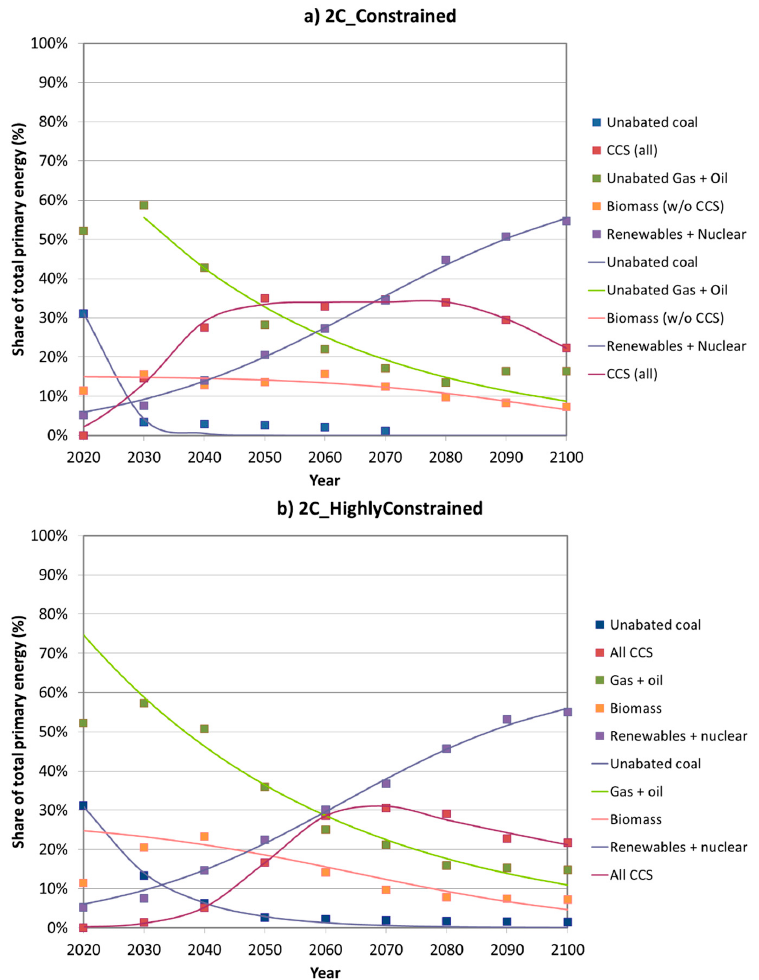
Figure 8. World share of primary energy use (%) for ( a ) 2C_Original and ( b ) 2C_HighlyConstrained scenarios. Notes: Symbols indicate data from scenario projections and solid lines indicate fit using a multiple logistic substitution model, as described in Annex E.